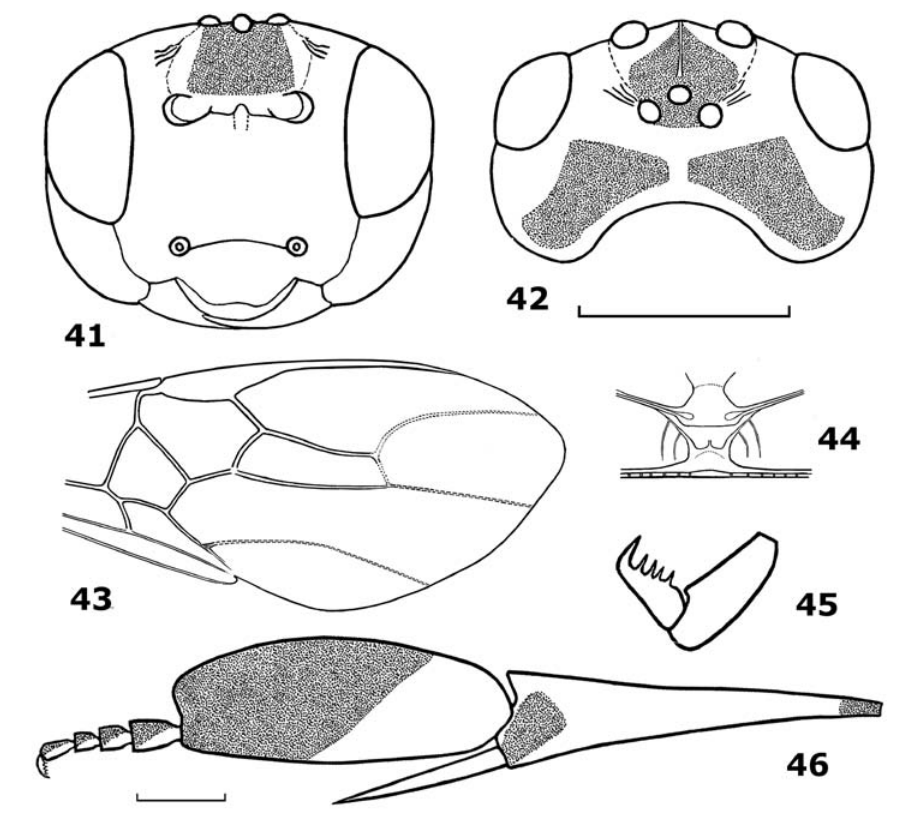
Figures 41–46 . Hartemita vietnamica sp. n., male, holotype. 41 head frontal 42 head dorsal 43 fore wing 44 metanotum dorsal 45 hind tarsal claw 46 hind tibia and tarsus. tarsus 2.7 times as long as wide (Fig. 46); hind basitarsus 1.3 times wider than apical width of hind tibia; inner hind tibial spur 0.5 times as long as hind basitarsus; second- fifth hind tarsal segments 0.4 times as long as hind basitarsus (Fig. 46); hind tarsal claw with 4 teeth (Fig. 45). Metasoma . Second tergite shorter than third tergite. Colour . Body and palpi yellow; antenna brown, but scapus yellow with dark brown spot apically and on outer side; frons black; vertex yellow anteriorly and black posteri- orly (Fig. 42); middle and lateral lobes of mesoscutum black; mesosternum black dor- sally and yellow ventrally; middle leg yellow, but outer side of trochantellus black; hind coxa dorso-apically, trochanter and trochantellus, basal ring of hind tibia, apical half of hind basitarsus dark brown or black; second-fifth hind tarsal segments dirty brown. Female . Unknown. Distribution. N Vietnam: Vinh Phuc and C Vietnam: Nghe An. Etymology. The species is named after the country of origin: